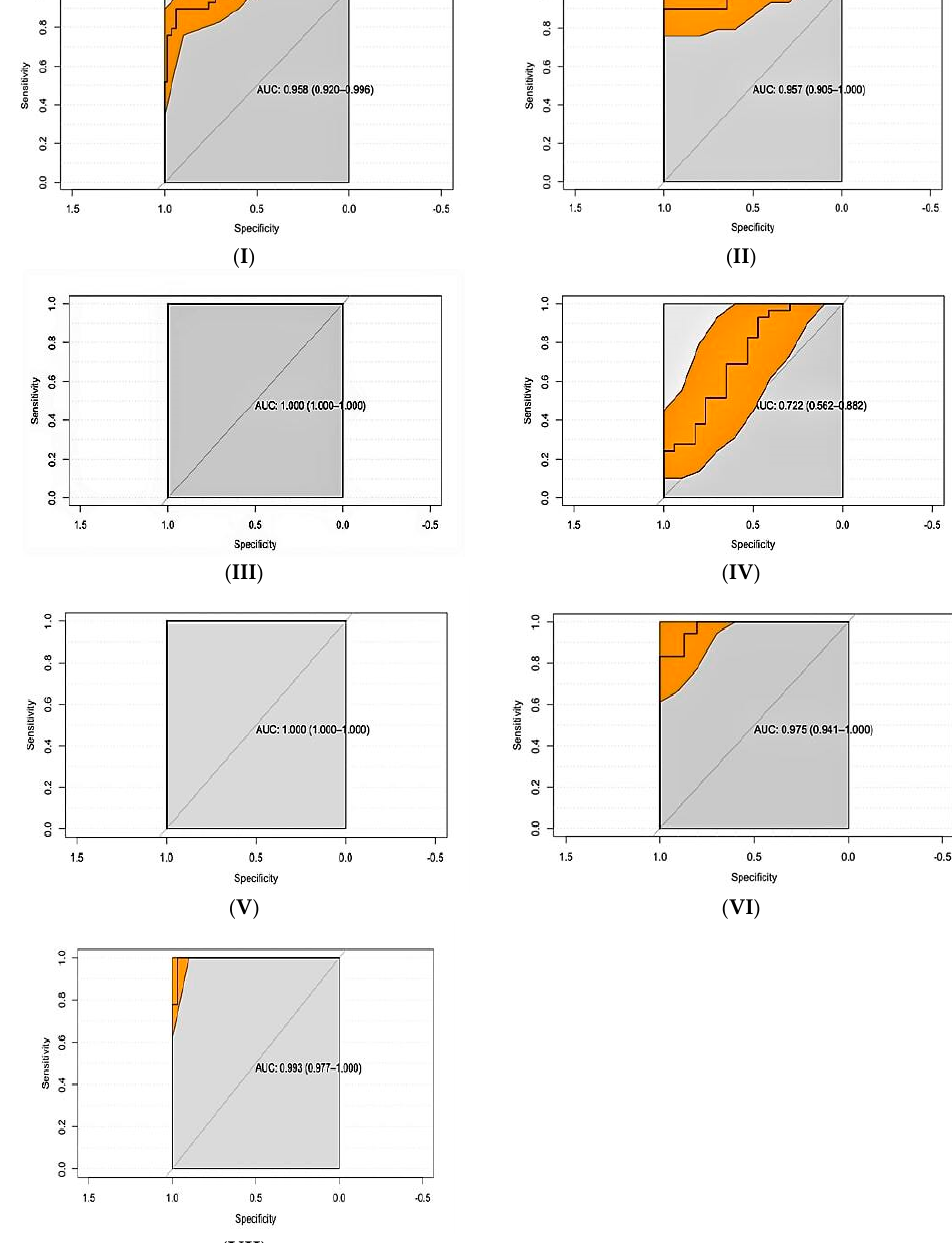
Figure 2. Plot of the Receiver Operating Characteristic (ROC) curve analysis for the following combinations: group A and B for the rLPS antigen in domestic pigs ( I ); group A and C for the rLPS antigen in domestic pigs ( II ); group A and B for the smooth B. suis 1330 antigen in domestic pigs ( III ); group A and C for the smooth B. suis 1330 antigen in domestic pigs ( IV ); group A and C for the ratio of smooth B. suis 1330/the smooth Y. enterocolitica O:9 in domestic pigs ( V ); group A and B for the rLPS antigen in wild boars ( VI ); group A and B for the smooth B. suis 1330 antigen in wild boars ( VII